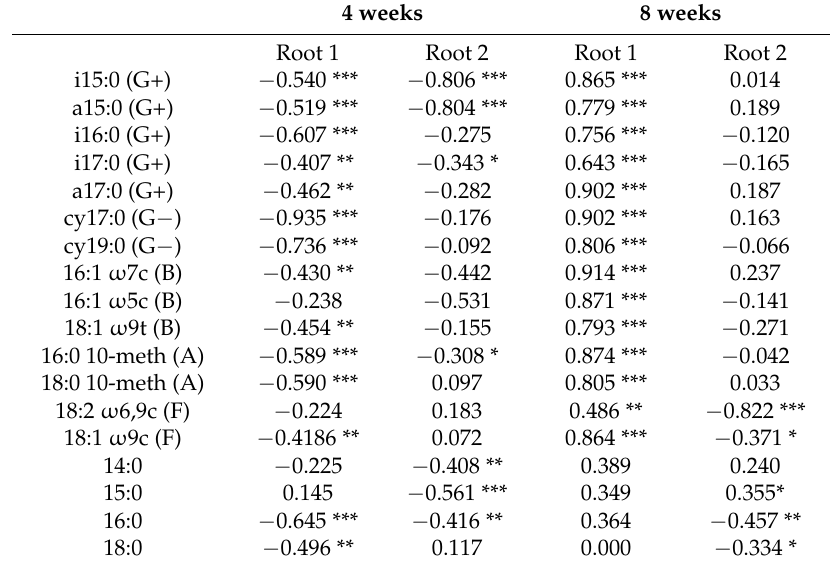
Figure 2. Discriminant function analysis of soil phospholipid fatty acid pattern at 4 weeks after nematode inoculation. The model used trophic groups of nematodes as groups ( n = 8) and PLFAs ( n = 13) as dependent variables. Control—no nematodes inoculated, bacterial feeders—BF ( Acrobeloides buetschlii ), fungal feeders—FF ( Aphelenchoides saprophilus ), plant feeders—PF ( Pratylenchus penetrans ). Table 2. Pearson correlation coefficients for phospholipid fatty acids with the first and second root in the discriminant function analyses at 4 and 8 weeks after nematode inoculation. Control—no nematodes inoculated, bacterial feeders—BF ( Acrobeloides buetschlii ), fungal feeders—FF ( Aphelenchoides saprophilus ), plant feeders—PF ( Pratylenchus penetrans ) . *, **, and *** with p < 0.05, 0.01, and 0.001. (Table from Maboreke [35], modified). 4